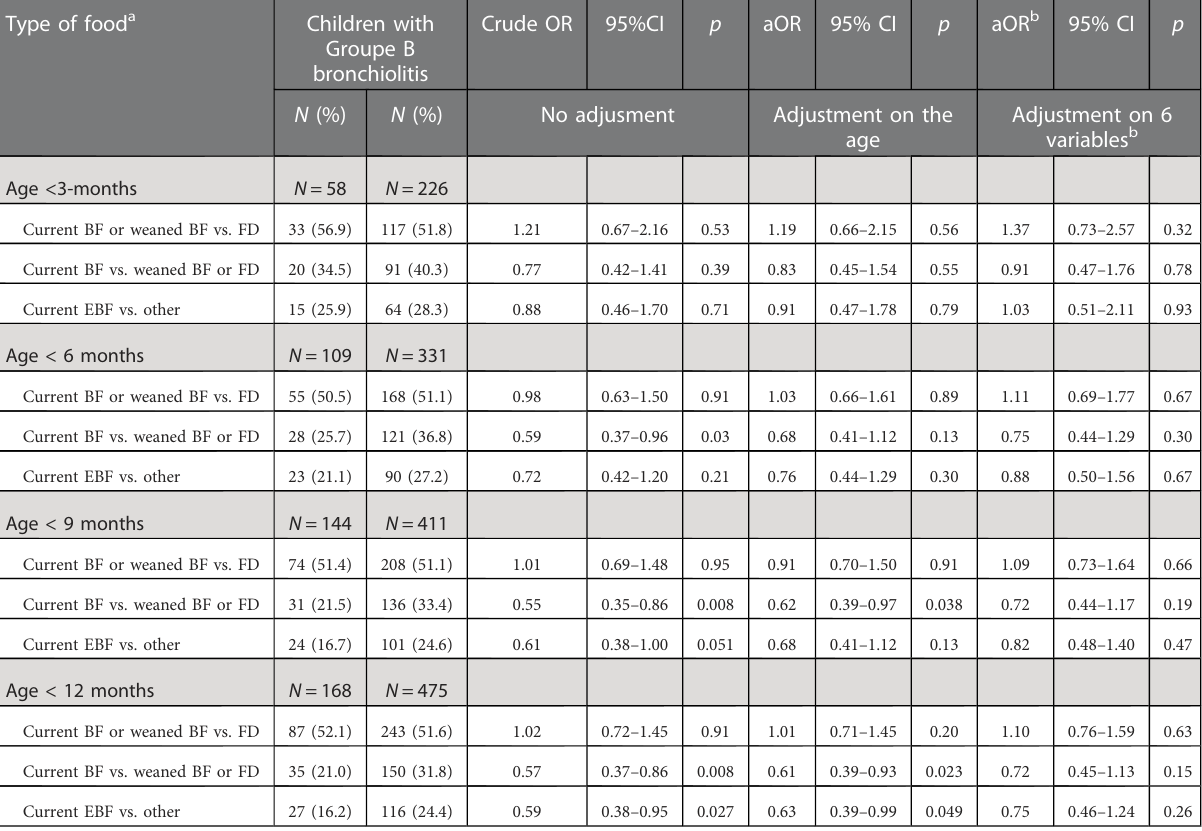
TABLE 6 Comparison of feeding method since birth between children with bronchiolitis and non-infected children (group B). Type of food